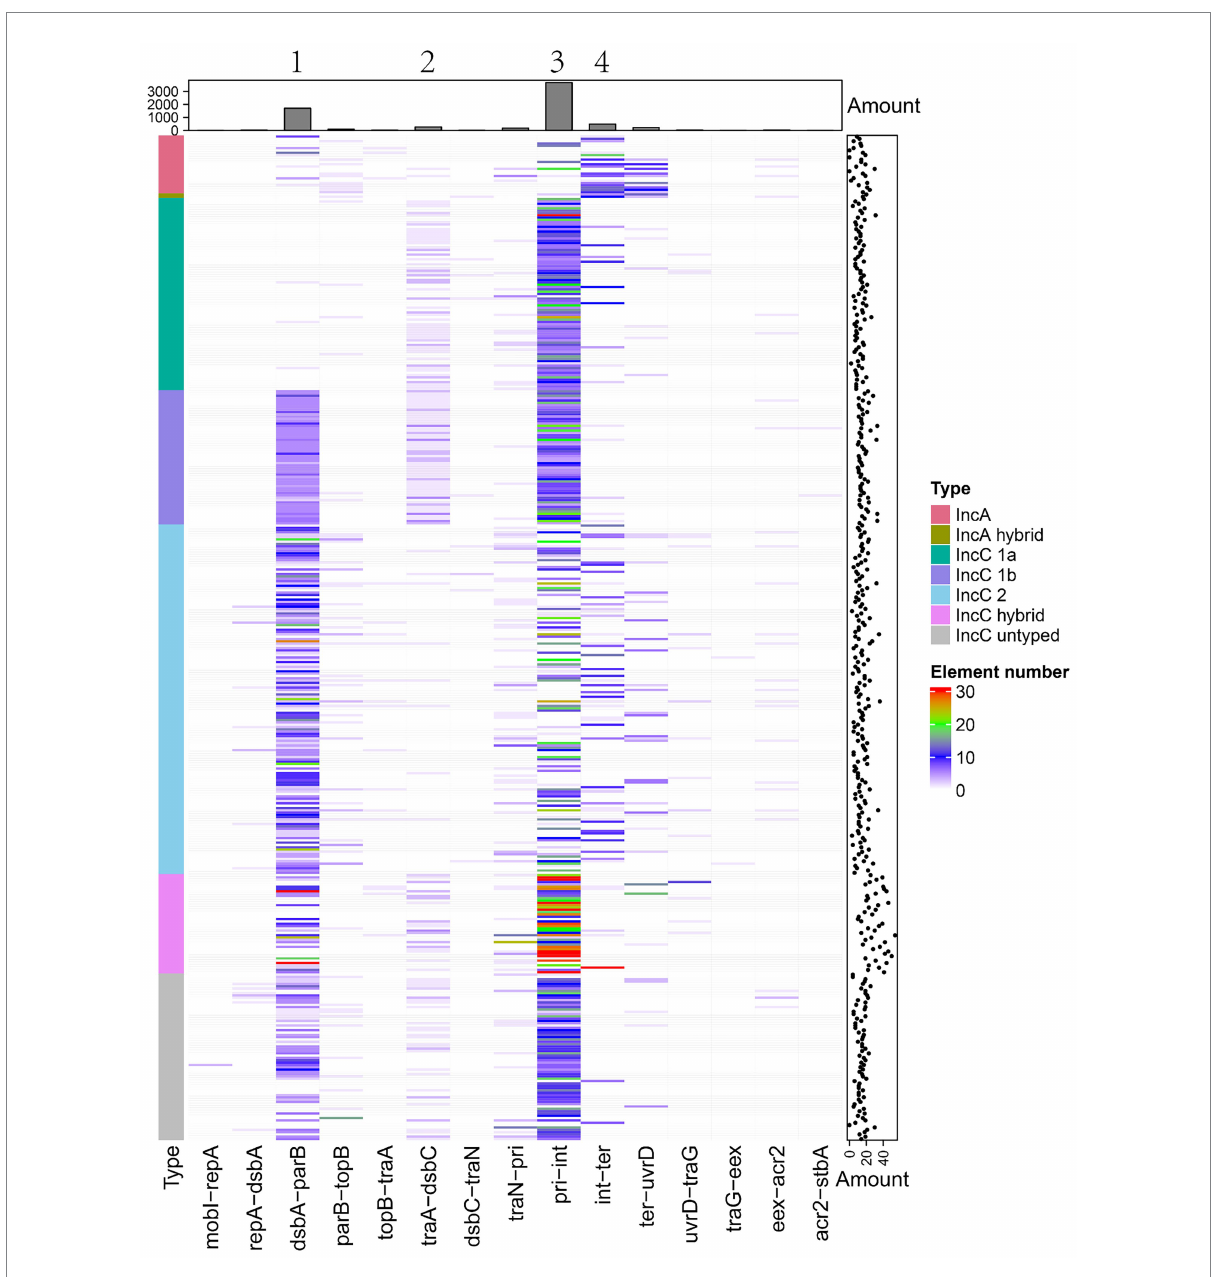
FIGURE 6 The distribution of insertion spots of IncA and IncC plasmids. Heatmap shows the presence and absence situations of mobile genetic elements (MGEs) in different types of plasmids. Both the bar charts and the scatter plots show the number of